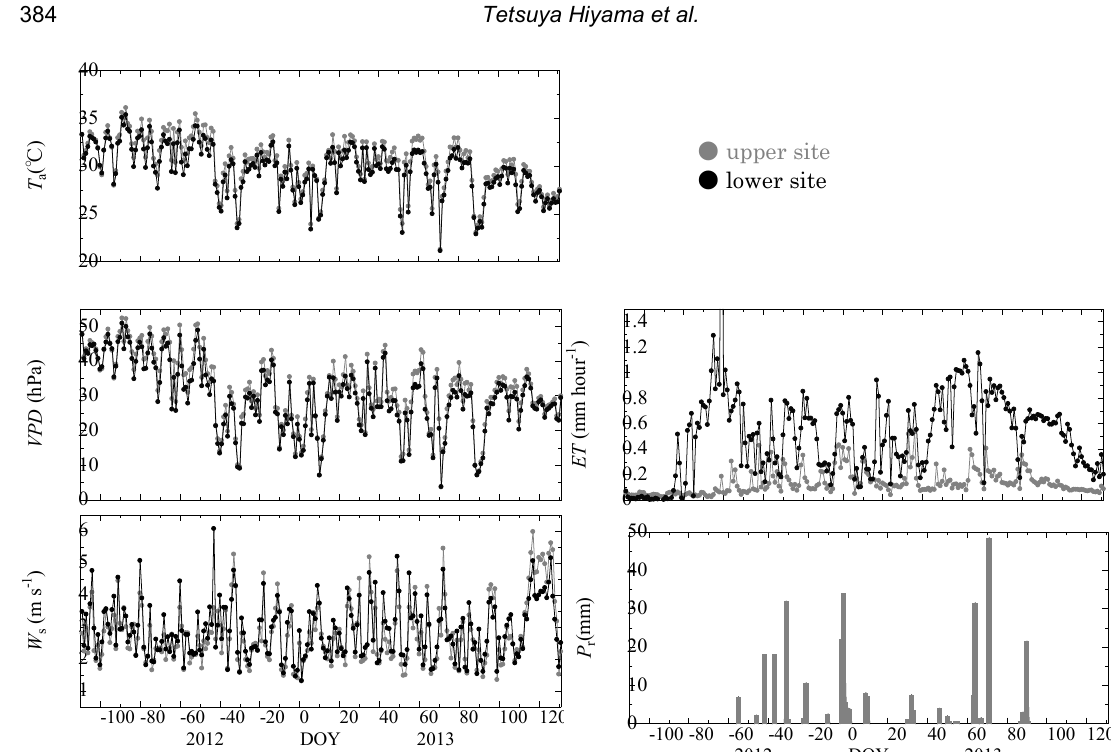
Fig. 2 Time series of air temperature ( Ta ), vapour pressure deficit ( VPD ), wind speed ( Ws ), daytime evapotranspiration ( ET ), and precipitation ( Pr ) at the upper and lower sites of the sloped experimental field at Ogongo campus, University of Namibia (UNAM). DOY is the day of the year 2013. (DOY 1 means 1 January 2013.)